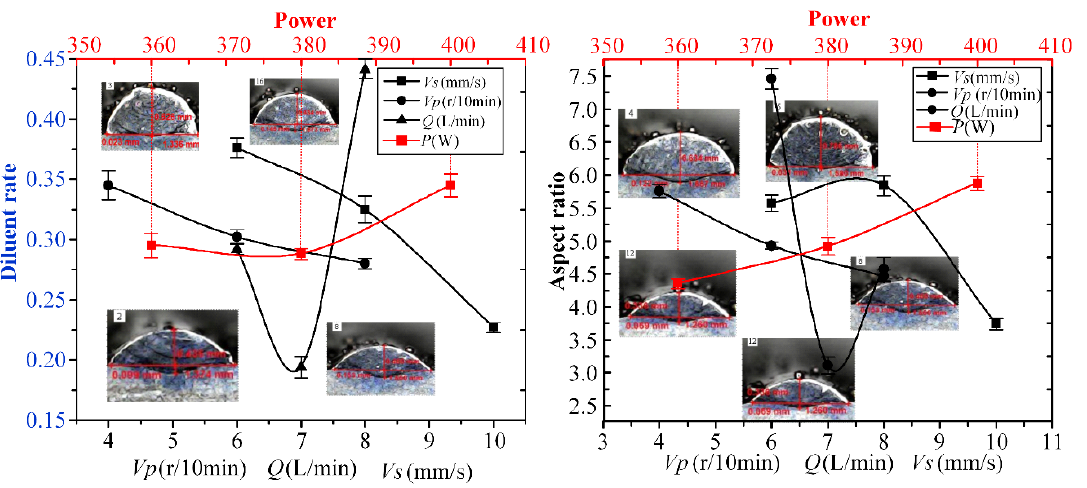
Figure 6. Analysis of the orthogonal experiment. Table 4. The results of the orthogonal